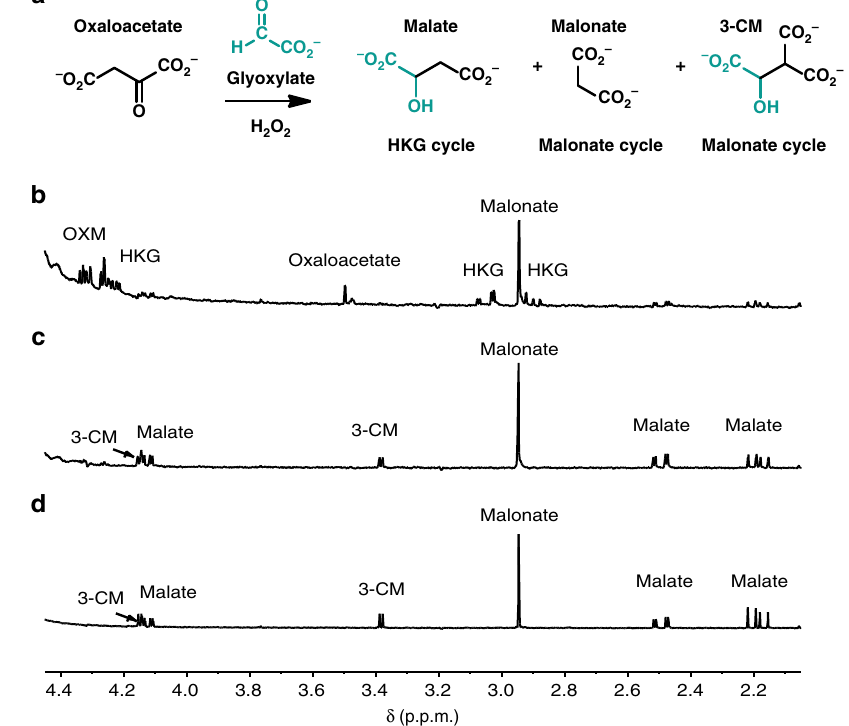
Fig. 5 Both HKG and Malonate pathways progress in the presence of glyoxylate and H 2 O 2 . a Intermediates of both pathways are detected, OXM, HKG, and malate from the HKG cycle, and malonate and 3-CM from the Malonate cycle. b 1 H NMR (in D 2 O) of a reaction aliquot from 90 mM oxaloacetate, 1.25 eq. glyoxylic acid, with 5 eq. of H 2 O 2 added over 1 h, in 1.0 M phosphate buffer, pH 7.0, at 23 °C for 10 min, c for 30 min, and d for 48